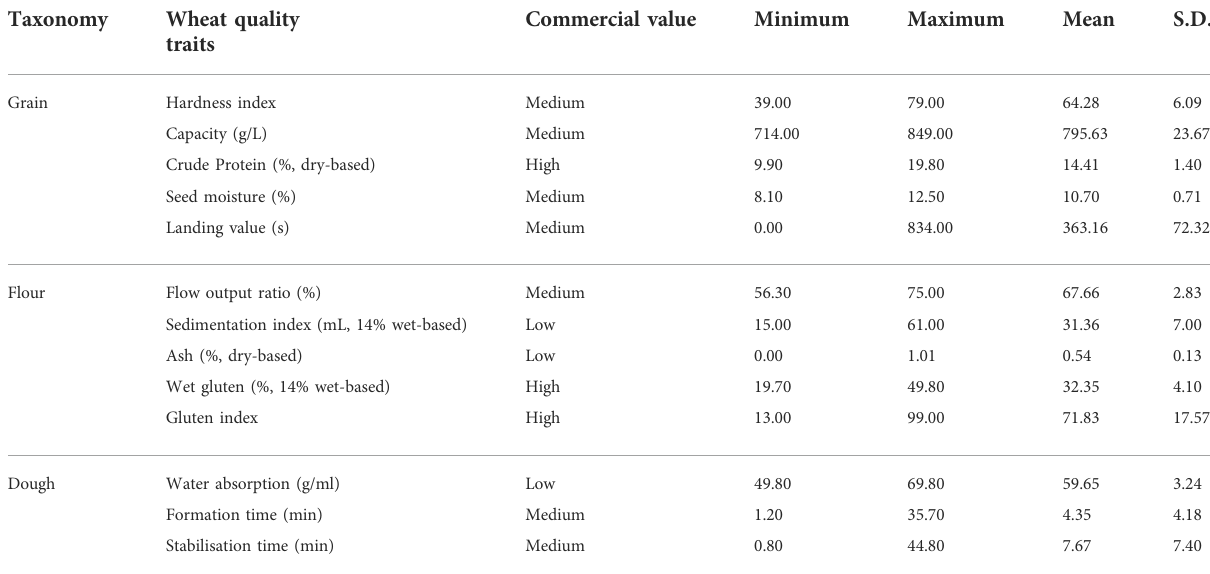
TABLE 1 Descriptive statistics of wheat quality traits.